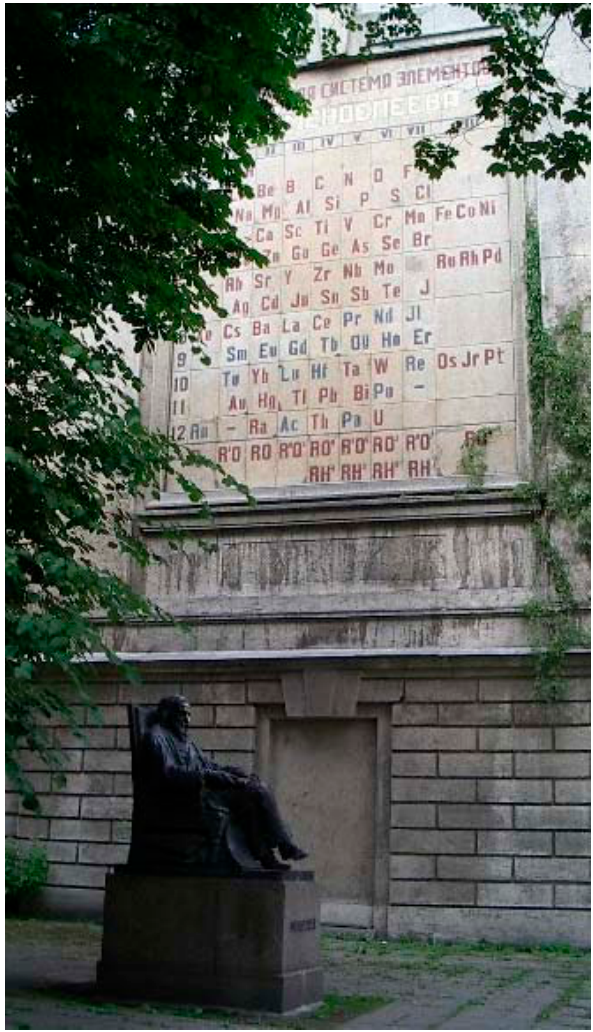
Figure 7. Mendeleev Monument (Ilya Ginzburg, 1930). On the wall behind is the famous giant version of the Periodic Table. The build- ing is the former Bureau of Weights and Measures where Mende- leev was Director. It now houses the Mendeleev All-Russian Insti- tute of Meteorological Research. Photograph: Mary Virginia